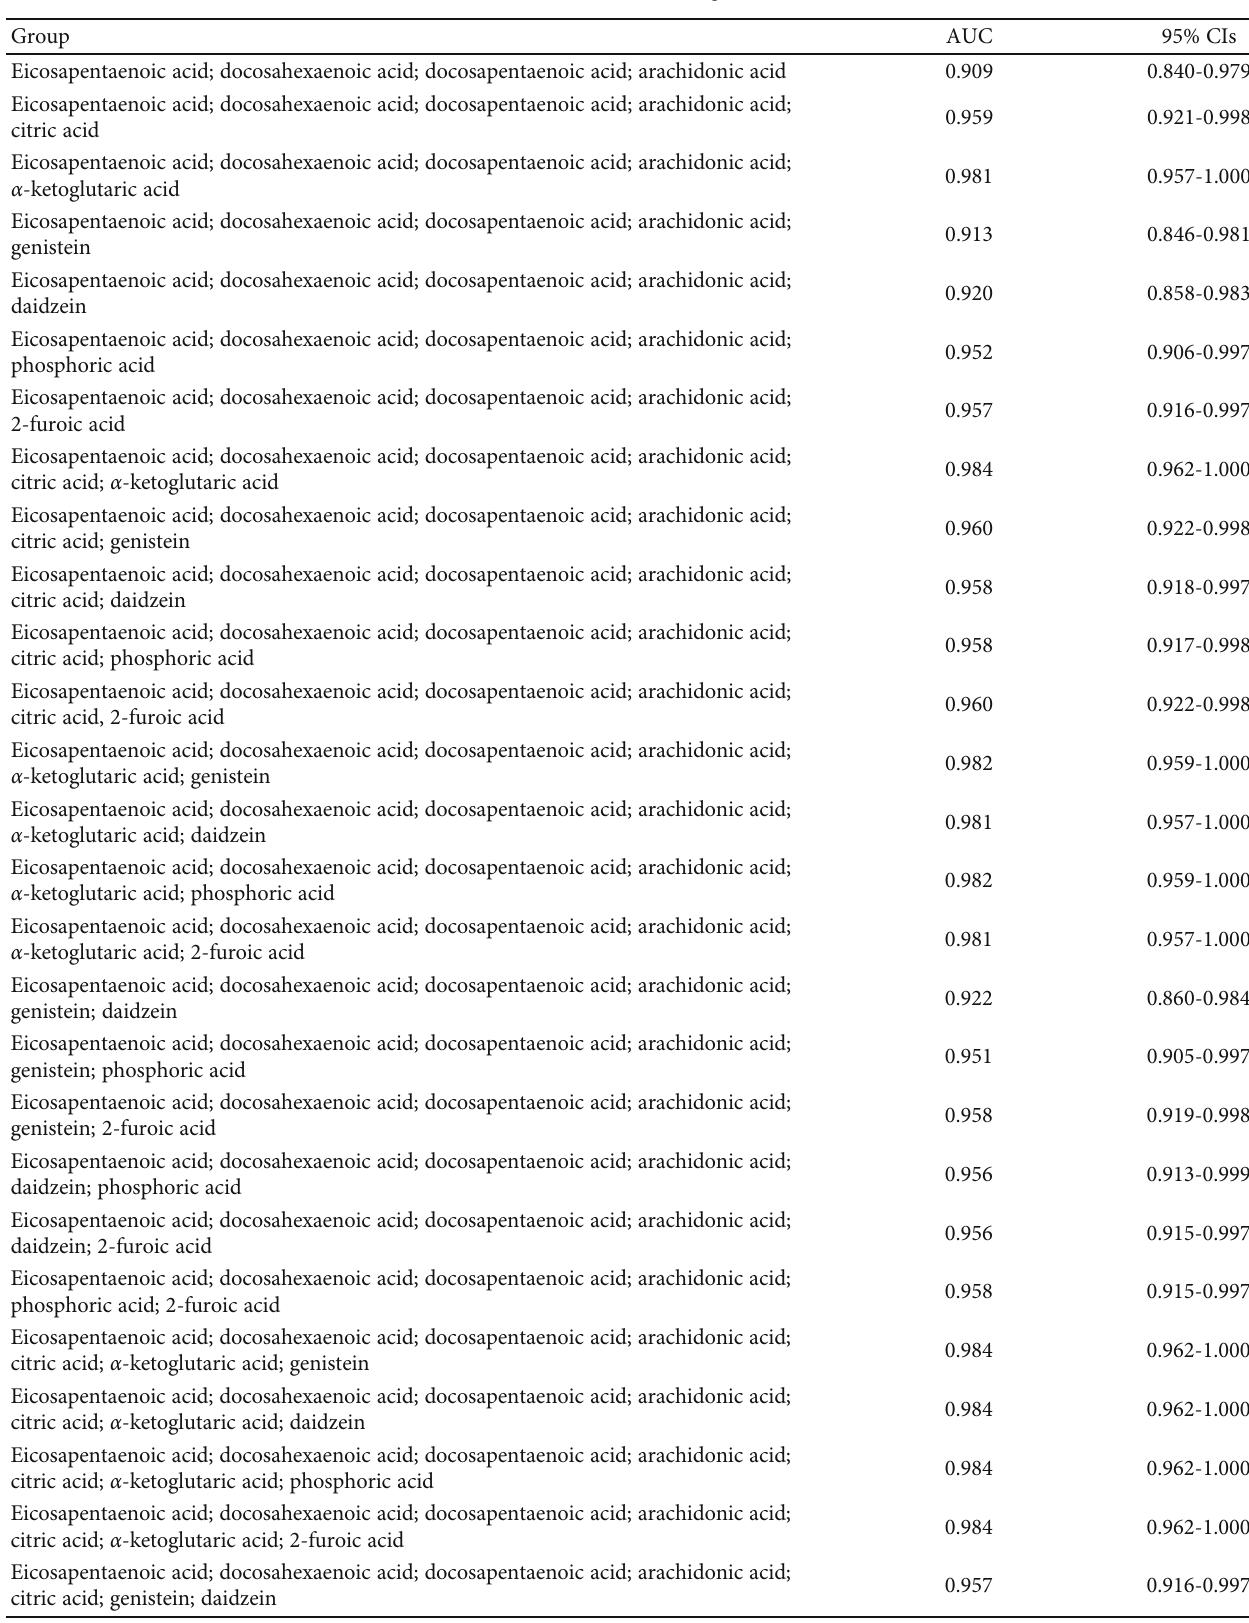
Table 3: Area under the curves among GDM and